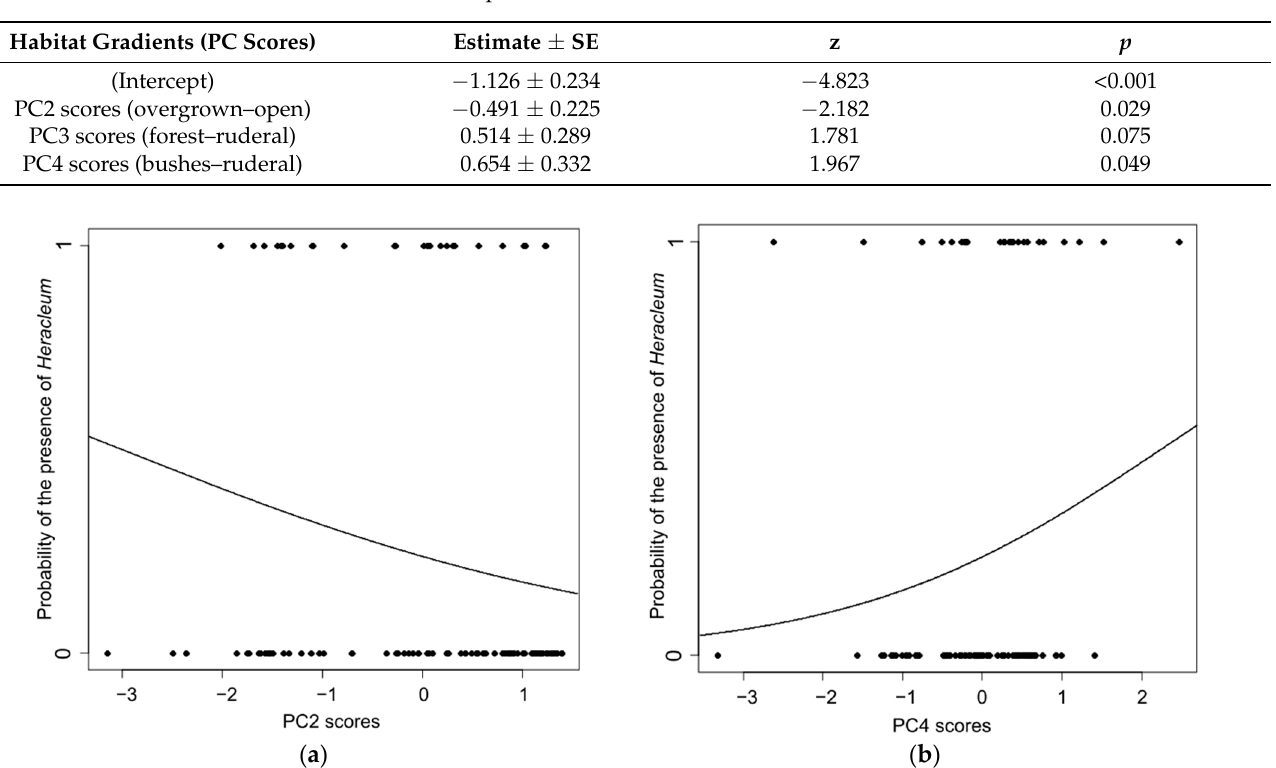
Table 4. The generalized linear mixed model with the presence or absence of invasion of Caucasian hogweeds as a binomial dependent variable and the best-fitted set of habitat gradients (PC scores) used as continuous predictors. “Site ID” was the random effect.